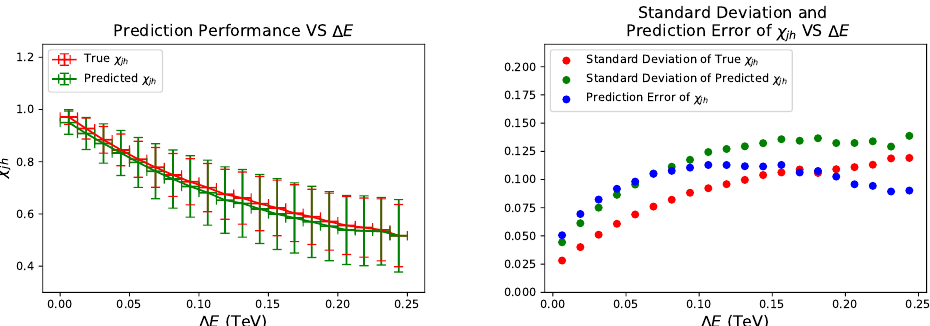
Figure 24 . Prediction Performance (left panel) and Standard Deviation, Prediction Error (right panel) VS Jet energy loss ∆ E ≡ E h